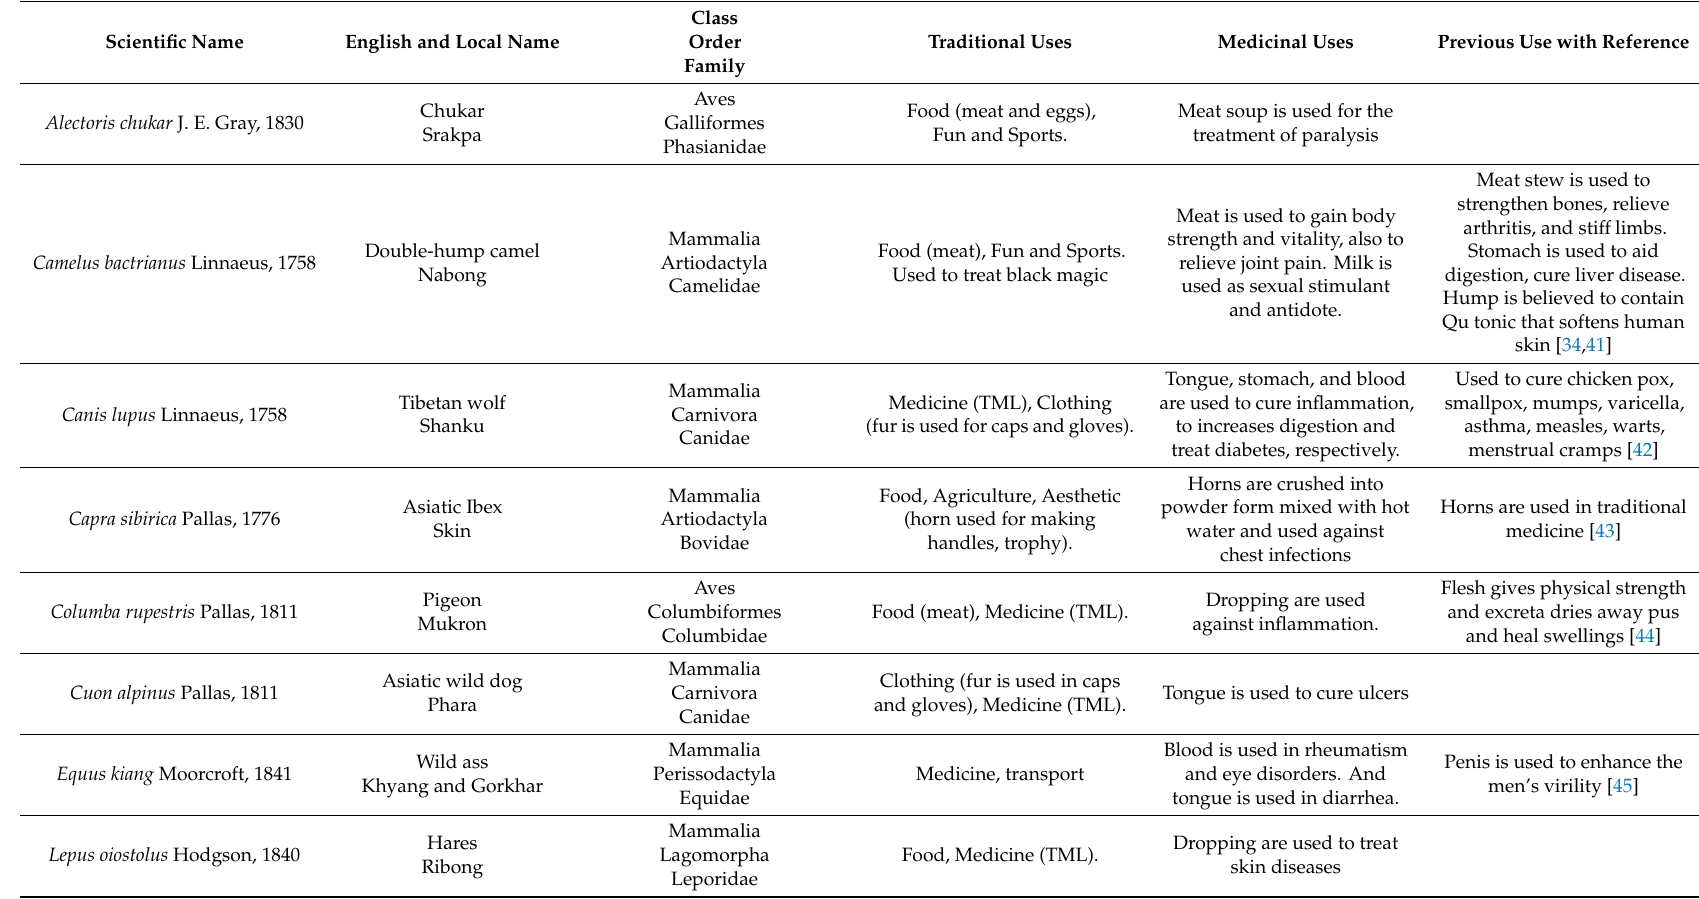
Table 2. Animal species recorded and their ethno-zoological usage in Ladakh region, Trans Himalayas,